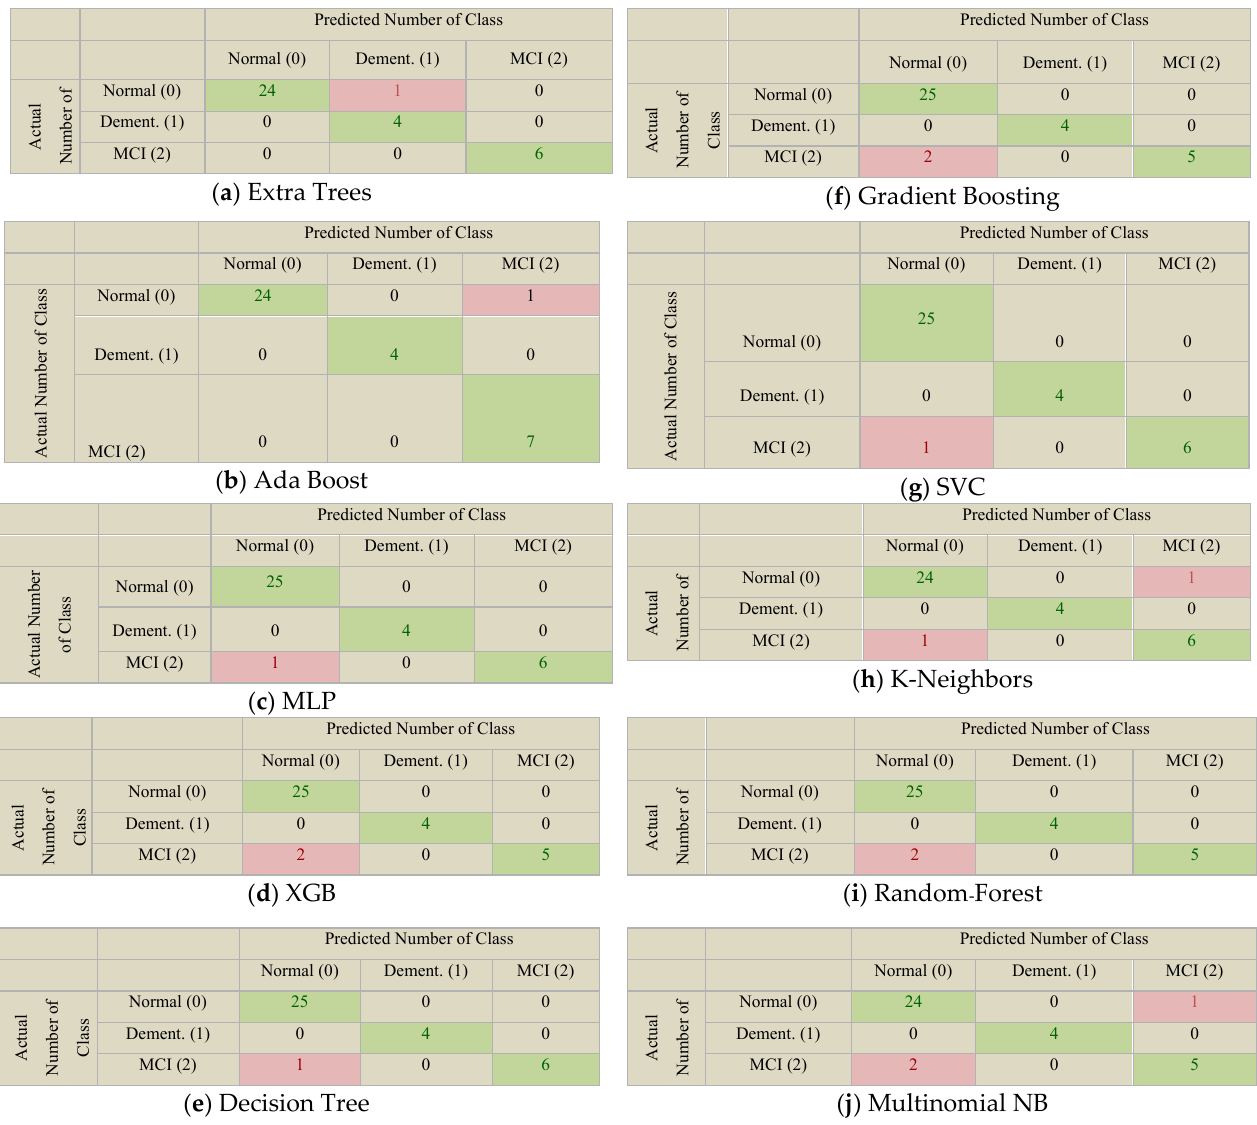
Figure 5. Confusion Matrix for multi-categorical classification models: ( a ) Extra Trees, ( b ) AdaBoost, ( c ) MLP=Multilayer Perceptron, (d) XGB = X-Gradient Boosting, ( e ) DT = Decision Tree; ( f ) GB = Gradient Boosting, ( g ) SVC = Support Vector Classifier, ( h ) K-N = K-Neighbors, ( i ) RF = Random Forest, ( j ) MNB = Multinomial Naive Bayes. Note: Correct class with green box, wrong class with red box.